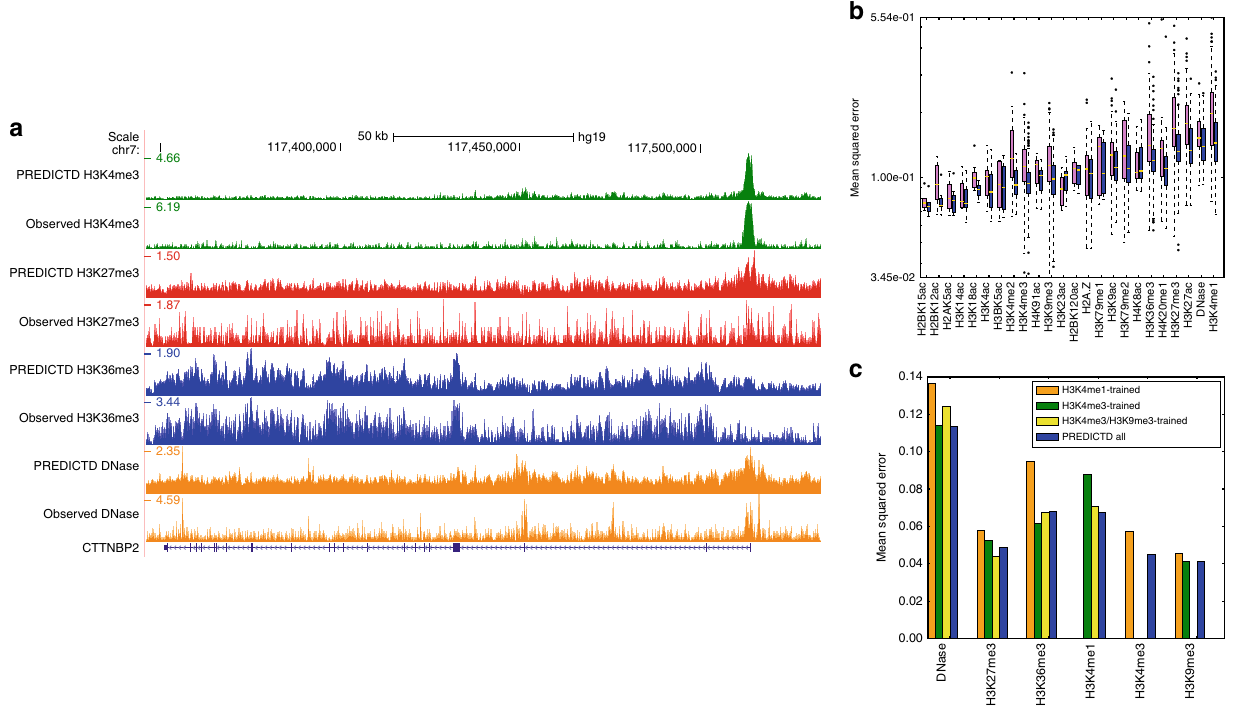
Fig. 2 PREDICTD imputes missing epigenomics data with high accuracy. a Comparison of PREDICTD and observed data in H1 embryonic stem cells, which is one of the three cell types with observed data for all assays. For each assay, the top track is PREDICTD and the bottom is observed. See Supplementary Fig. 1 for more assays. b Global mean squared error (MSEglobal) for each dataset, shown as box plots for the baseline Main Effects model (pink), and PREDICTD (blue). For each distribution, the box shows the inter-quartile range (IQR), whiskers show 1.5 times the IQR, and fl ier points show individual datasets that are outliers. The median is indicated by a horizontal gold line on each box plot. See Supplementary Fig. 2 for more quality measures. c Simulated analysis of a cell type with few available datasets. The bar graph shows the MSEglobal measure for the six available assays for the “ CD3 primary cells from cord blood ” cell type on four models. In blue is the full PREDICTD model shown in a and b , while the other bars represent models trained with all observed data for other cell types, but only H3K4me1 (orange), only H3K4me3 (green), or only H3K4me3 and H3K9me3 (yellow) for “ CD3 primary cells from cord blood. ” See Supplementary Fig. 3 for more quality